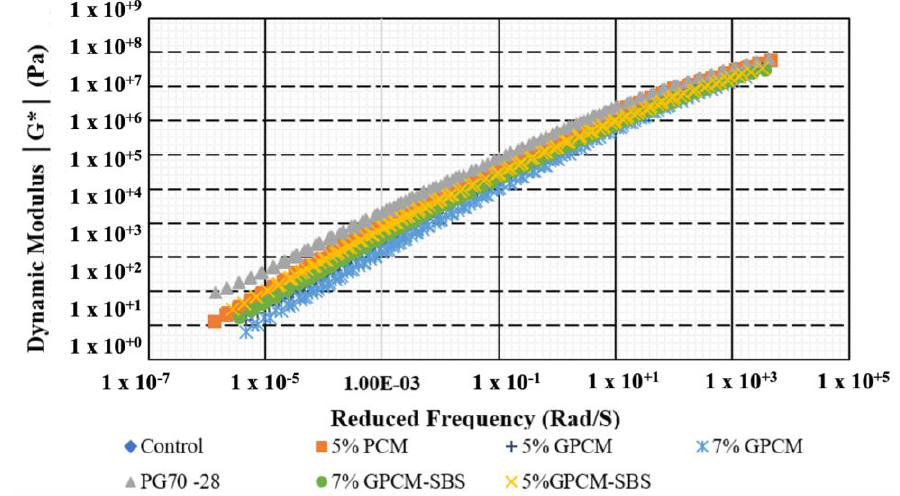
Figure 13. Master curves for all binders.